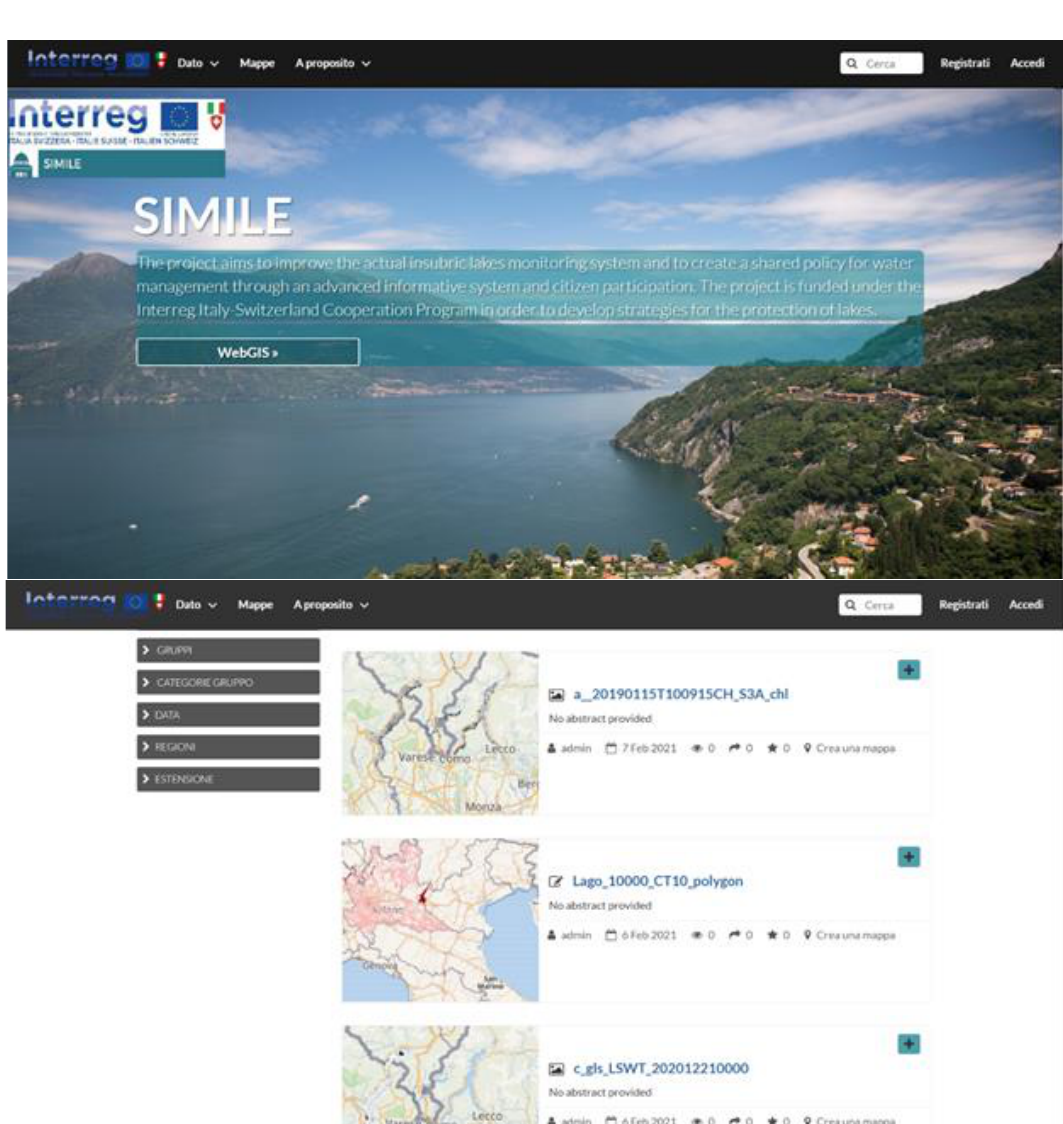
Figure 2. Customized GeoNode plaform user interface. Main page (top) and Layer page